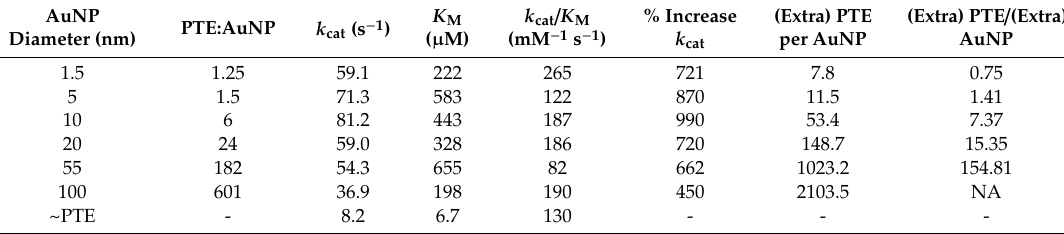
Table 5. Averaged enzyme activities for fixed enzyme density format for low coverage